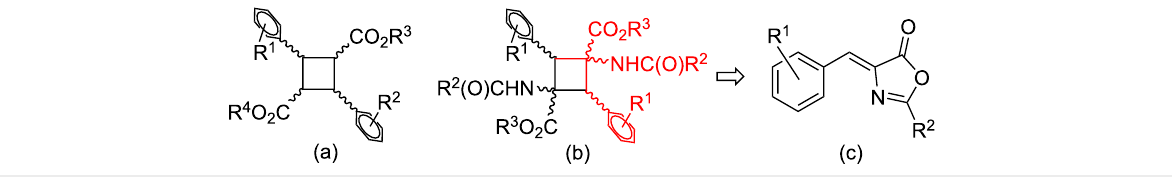
Figure 1: (a) General scheme for truxillic acid derivatives; (b) general scheme for symmetric 1,3-diaminotruxillic ester derivatives; (c) retrosynthesis: 4-arylidene-5(4 H )-oxazolones are optimal precursors.